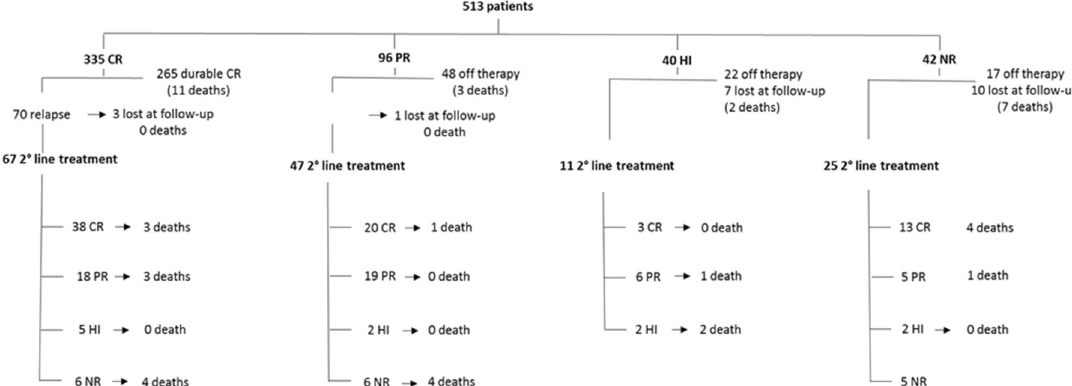
Fig. 1 Response to fi rst-line and salvage therapy. The diagram shows the deep of response and the outcome after fi rst-line therapy, the number of patients who underwent a second line teatment, and the deep of response and outcome of second-line therapy. CR complete response, PR partial response, HI hematological improvement, NR no